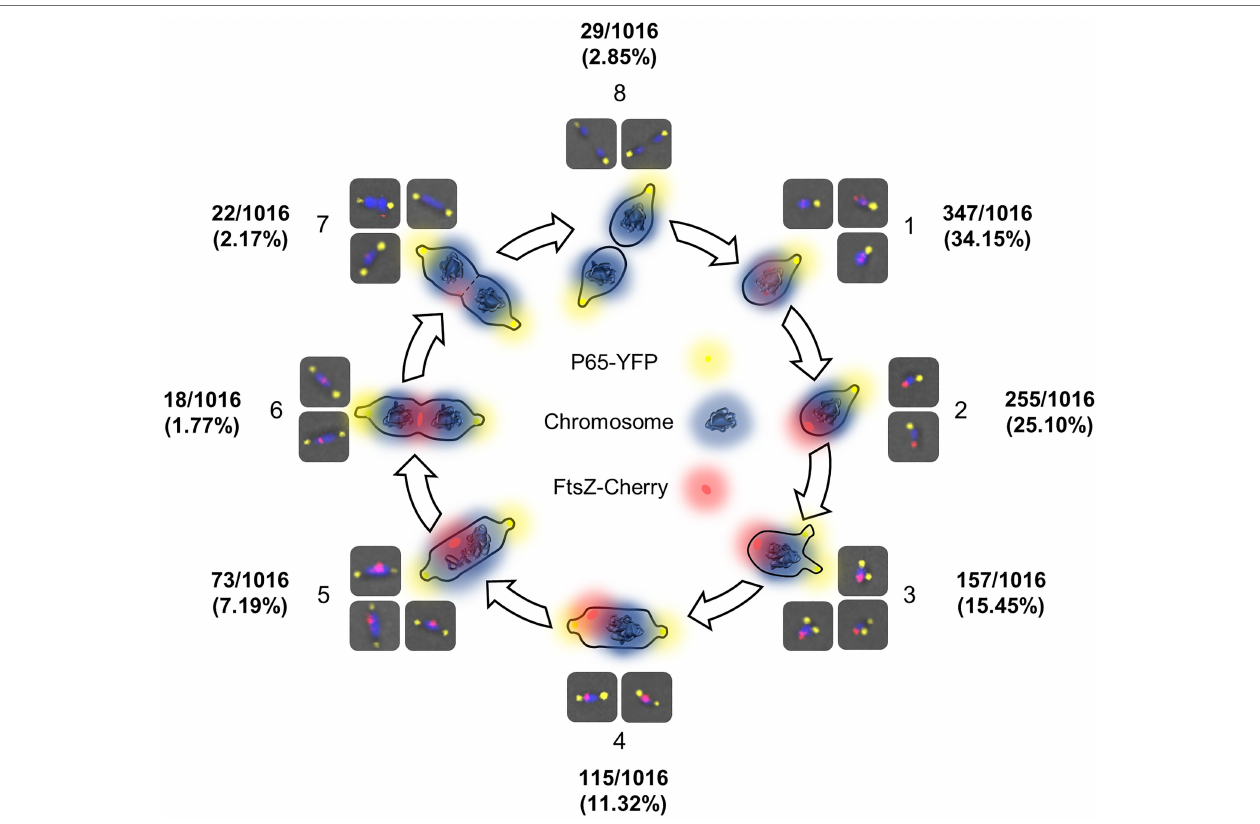
FIGURE 7 | FtsZ localization dynamics throughout the cell cycle of M. genitalium . Scheme depicting different stages of the M. genitalium cell cycle based on the localization of FtsZ foci relative to the terminal organelle (TMO) and the chromosome. In this model, FtsZ accumulates at the cell body (1) and clusters at the cell pole opposite to the TMO (2). Then, the TMO duplicates (3) and one TMO moves to the opposite cell pole (4). Next, FtsZ foci move to the midcell (5). Finally, cytokinesis starts (6) and the FtsZ signal decreases (7) until the process is completed